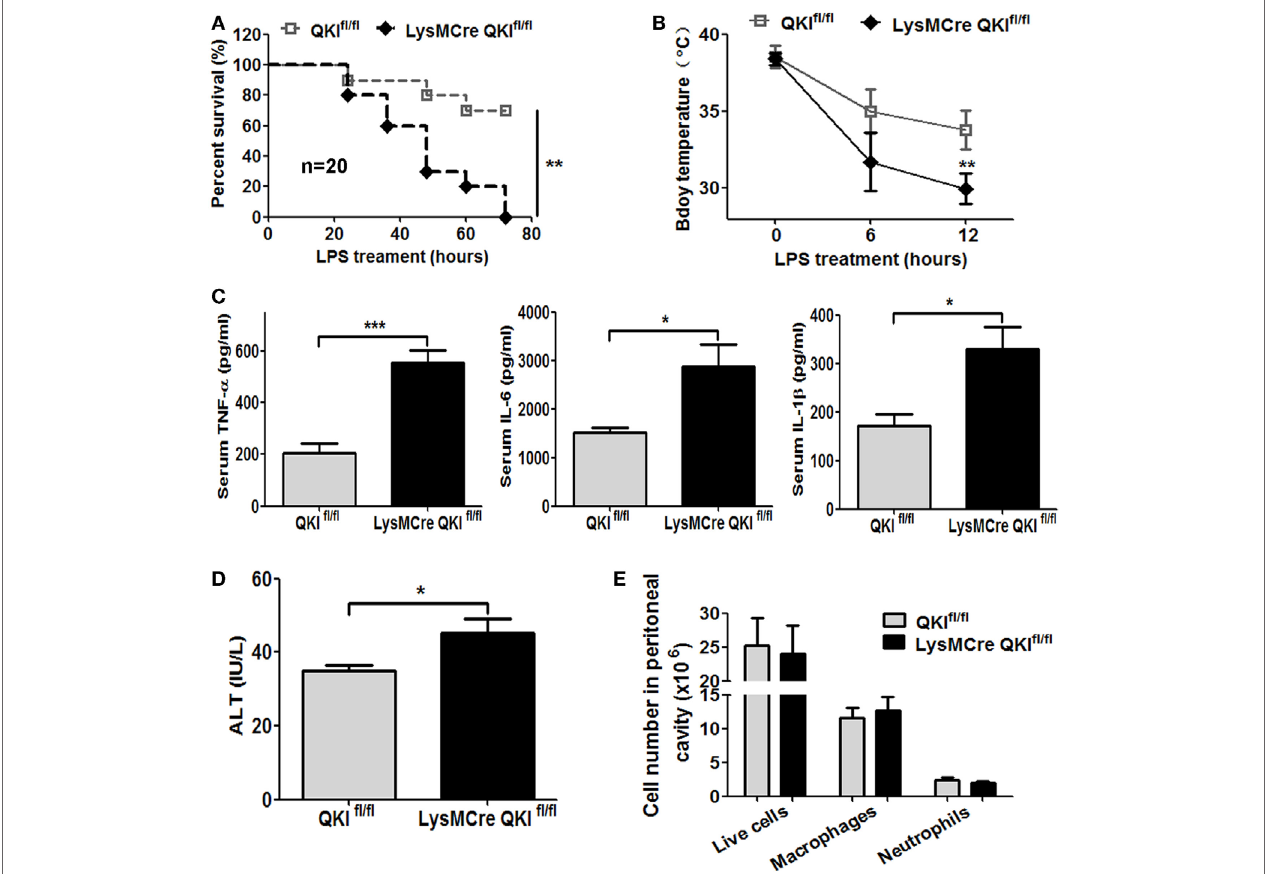
FigUre 6 | Macrophage-specific quaking (QKI) deficiency caused high susceptibility to endotoxic shock. (a) Age- and sex-matched QKI fl/fl and LysMcre QKI fl/fl mice were intraperitoneally injected with 50 mg/kg lipopolysaccharide (LPS). The survival was documented. The data shown are pooled from the two independent experiments ( n = 20). (B) Body temperature of QKI fl/fl and LysMCre QKI fl/fl mice LPS treatment and 6 h and 12 h after LPS injection was measured using a rectal thermometer. (c) QKI fl/fl and LysMCre QKI fl/fl mice were challenged with LPS. Serum was obtained 4 h after LPS injection. Inflammatory cytokines were analyzed by using the Dakawe mouse enzyme-linked immunosorbent assay (ELISA) kit. (D) QKI fl/fl and LysMCre QKI fl/fl mice were challenged with LPS. After 4 h, the serum of mice was obtained. Alanine aminotransferase (ALT) was tested to determine the extent of liver injury using the ALT assay kit. (e) Cells isolated from the mouse peritoneum 48 h post-LPS injection were stained with Wright-Giemsa. The number of total live cells, macrophages, and neutrophils were calculated. All the experiments were performed twice, independently and each time 10 mice/group were used in (a–D) . n = 20. In (e) , 6 mice/group were used. Data are presented as mean ± SEM. * p < 0.05, ** p < 0.01, *** p <